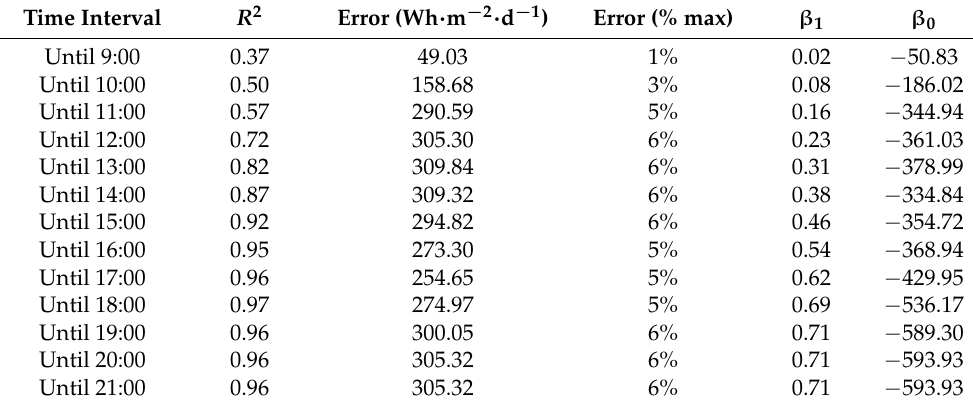
Table 1. Main parameters of regression adjustment.